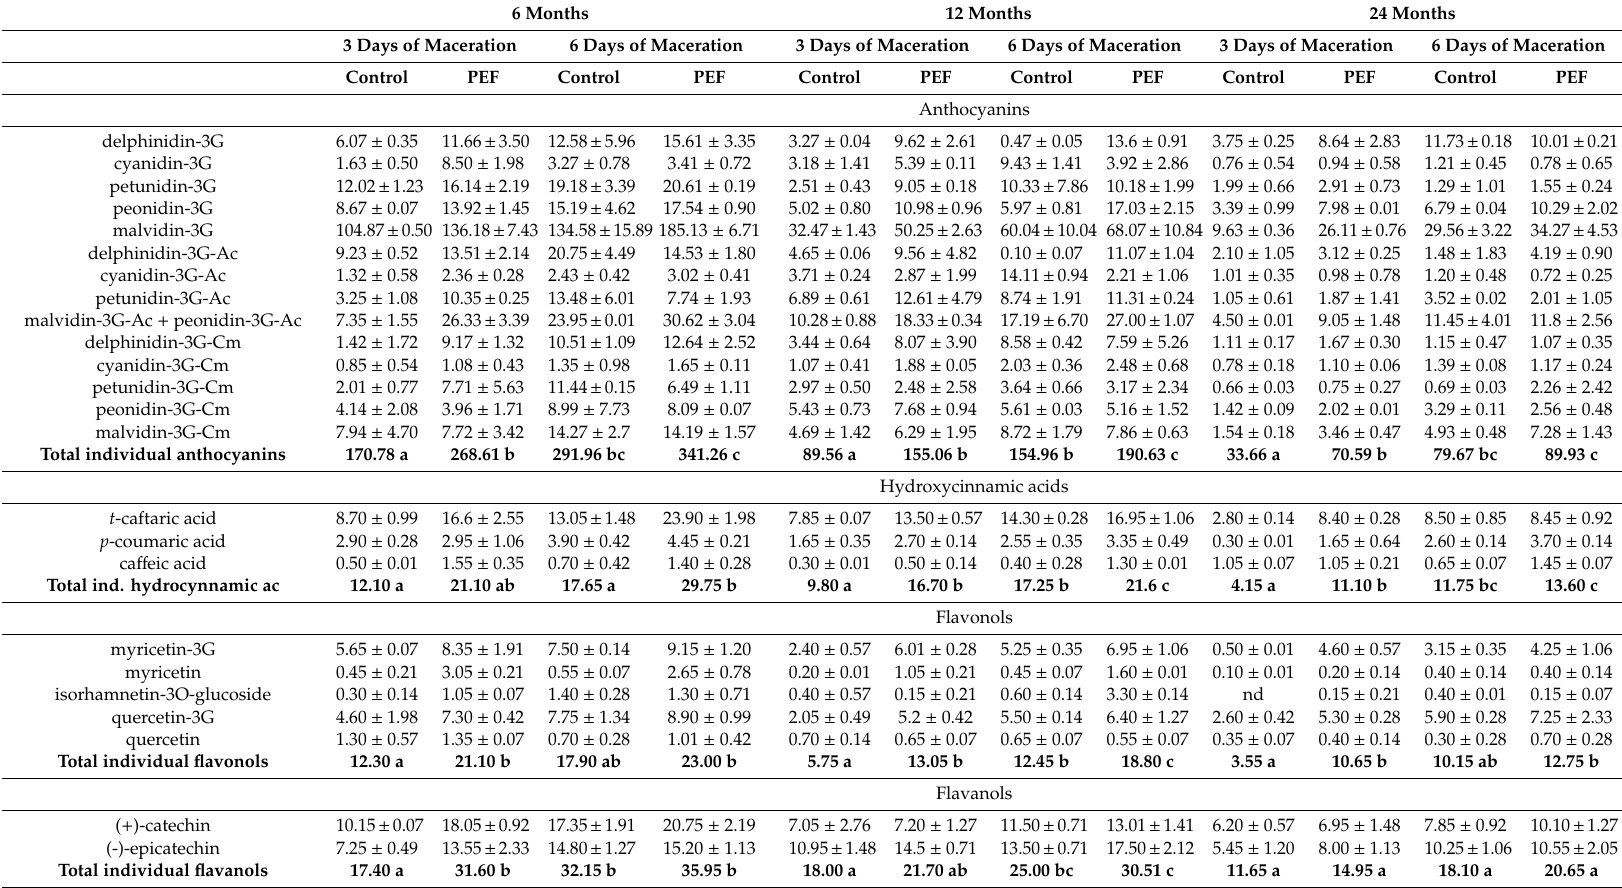
Table 2. Evolution of individual phenolic compounds (mg.L − 1 ) in wines obtained from untreated and PEF-treated grapes with 3 and 6 days of maceration after 24 months of bottle